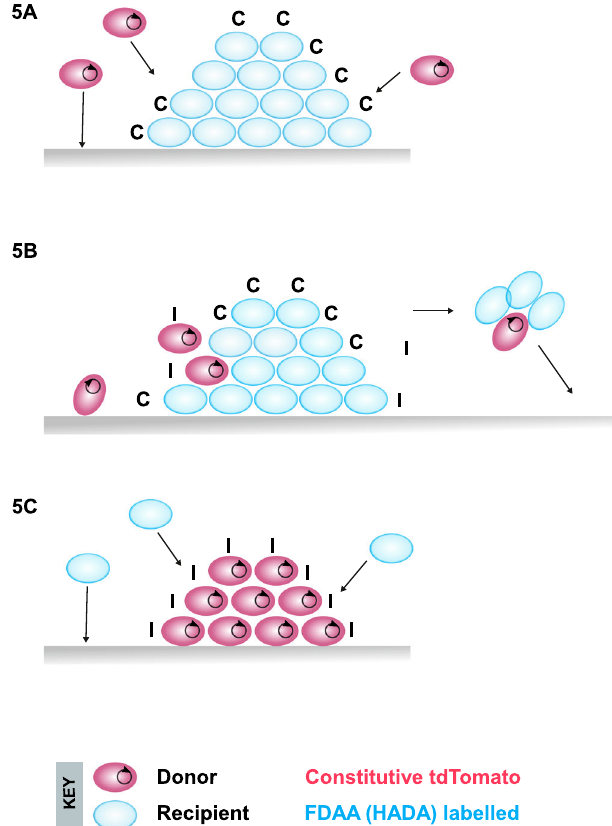
Fig. 5 Models for pCF10-mediated conjugation and invasion of resident populations in the mouse intestine. A Donors invade recipients Donor cells (blue) in the lumen can attach to recipient microcolonies (red), or directly to the mucosal surface. Because of the high pheromone C concentration in the colony, donors that attach are induced to transfer plasmids (black circles) to adjacent recipients. The spread of the plasmid through the microcolony is limited by the gradually increasing levels of I resulting from plasmid dissemination and from the pheromone-induced expression of the prgQ gene encoding the I peptide; this generates a colony comprised of plasmid- containing and plasmid-free cells. B Cells and small aggregates from the colony likely re-enter the planktonic phase by direct exit or when the colony is disrupted by turnover of the mucosal surface, and re-attach to generate new microcolonies. C Recipients invade donors when recipients invade a niche containing resident donors, the high pre-existing concentration of I coupled with the low population density of the C -producing invaders minimizes the expression of transfer functions. The rare transconjugants generated probably result from contact-dependent pheromone induction of donors adjacent to the attached recipient. Unless the invading recipients have a plasmid-independent fi tness advantage, the transconjugants have no advantage over the resident donors, and they are eventually eliminated, along with the unmated recipients are eliminated. As in B . cells and small aggregates from the colonies may re- enter the lumen and then re-attach, but this does not prevent the eventual elimination of the